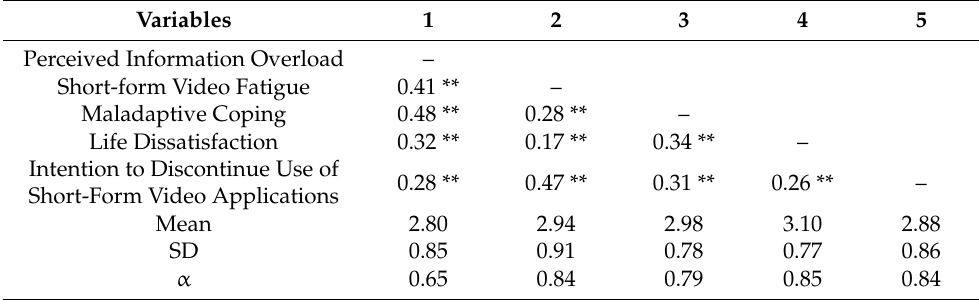
Table 3. Correlations between key variables.